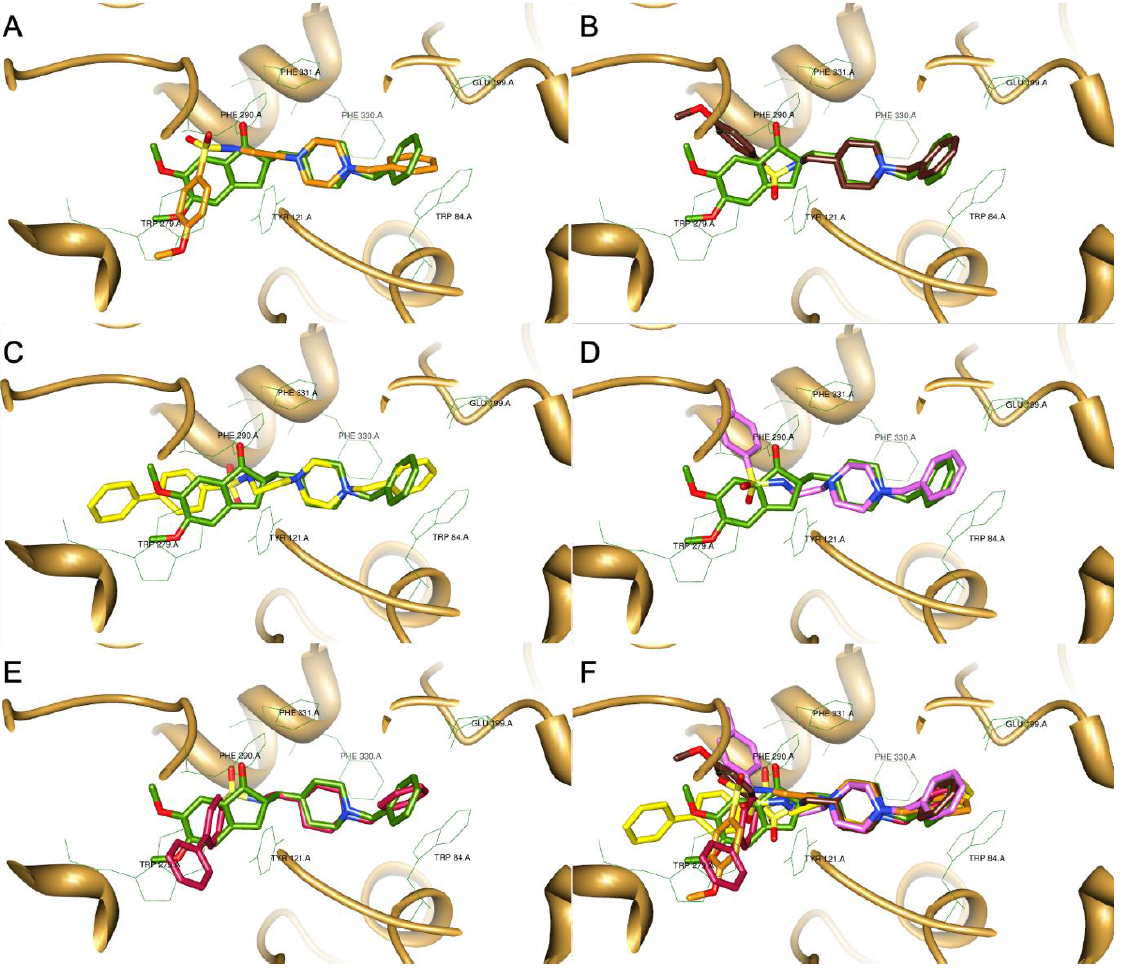
Figure 1. Superimposition of the different DNP-sulfonamide compounds with the original ligand (DNP-green), as a result of their docking inside the AChE active site (PDB code: 1EVE). ( A ) compound 6 ; ( B ) compound 8 ; ( C ) compound 7 ; ( D ) compound 5; ( E ) compound 9 ; ( F ) all the compounds.